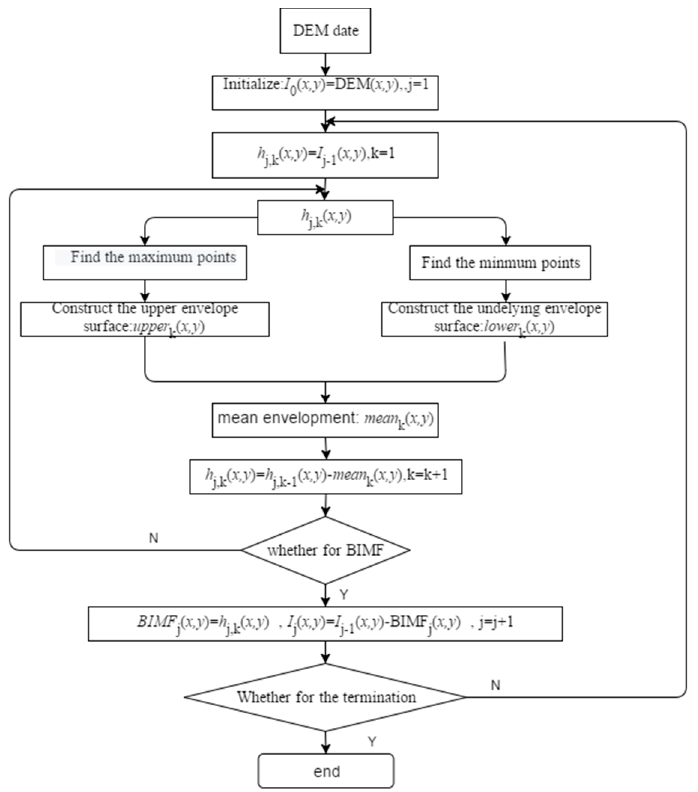
Figure 3. BEMD terrain decomposition process.